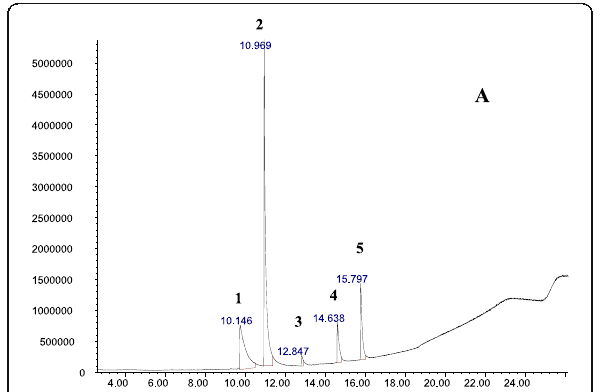
Fig. 3 GC chromatogram of sample A, peak 1 represents caffeine, 2 dextromethorphan, 3 hydromorphone, 4 acetylcodeine, and 5 heroin